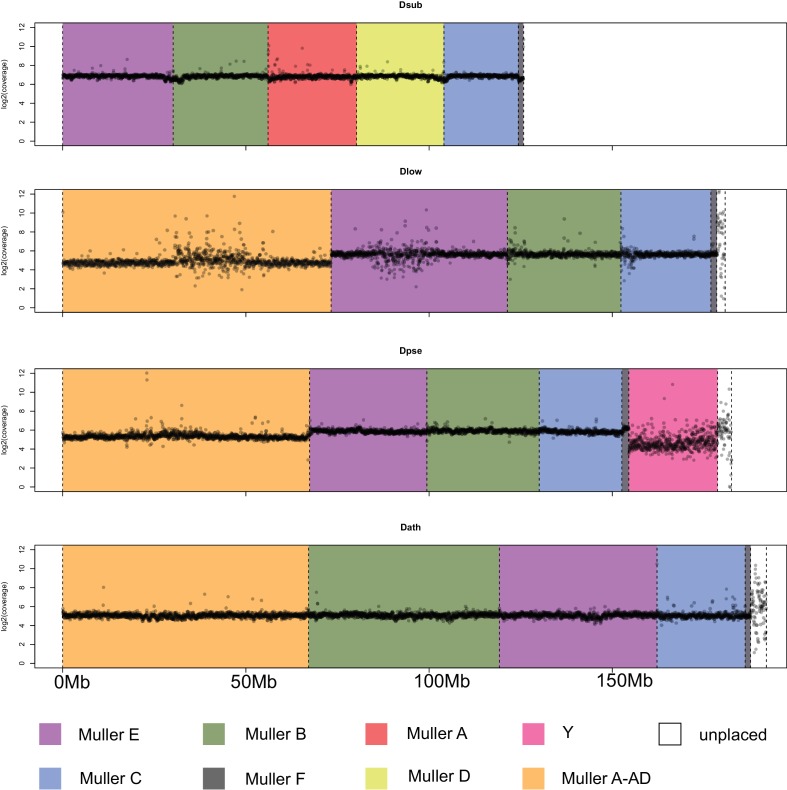
Nanopore or PacBio coverage over reference genome assemblies of D. subobscura, D pseudoobscura, D. lowei and D. athabasca.Coverage (log2) shown in 50 kb non-overlapping windows along the genome assembly with different genomic partitions highlighted. Contigs < 50 kb not shown. Note, D. lowei data was derived from males, D. subobscura and D. athabasca was derived from females, and D. pseudoobscura was derived from a combination of males and females. Therefore, coverage over A-AD is expected to be lower in D. lowei and D. pseudoobscura relative to the autosomes (Mullers B, C, E, F). Further, in D. pseudoobscura, A-AD and Y coverage is not expected to be similar due to differences in the female/male contribution to the total read pool.